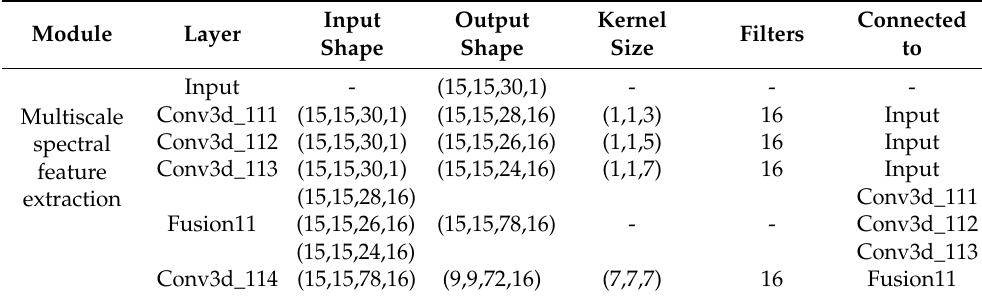
Table 1. The implementation details of the multiscale spectral feature extraction module.